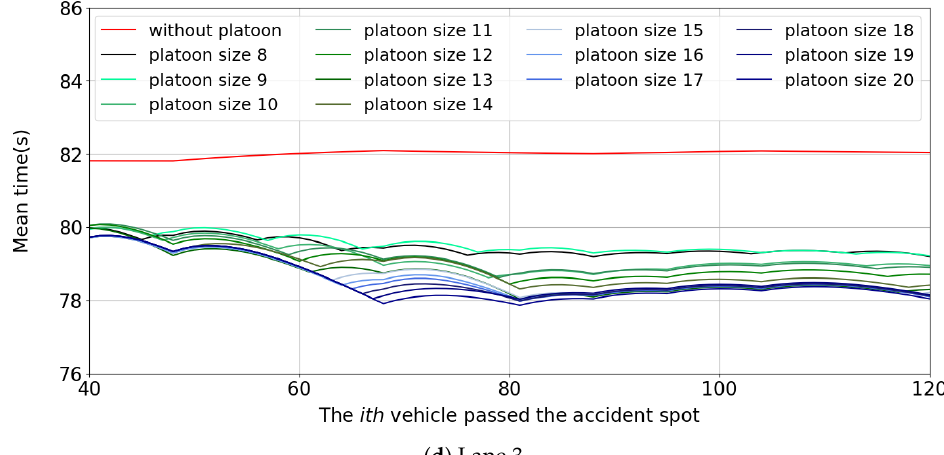
Figure 7. The mean time taken for the vehicles to exit the congestion spot if they receive an accident warning 2500 m ahead of the accident spot.